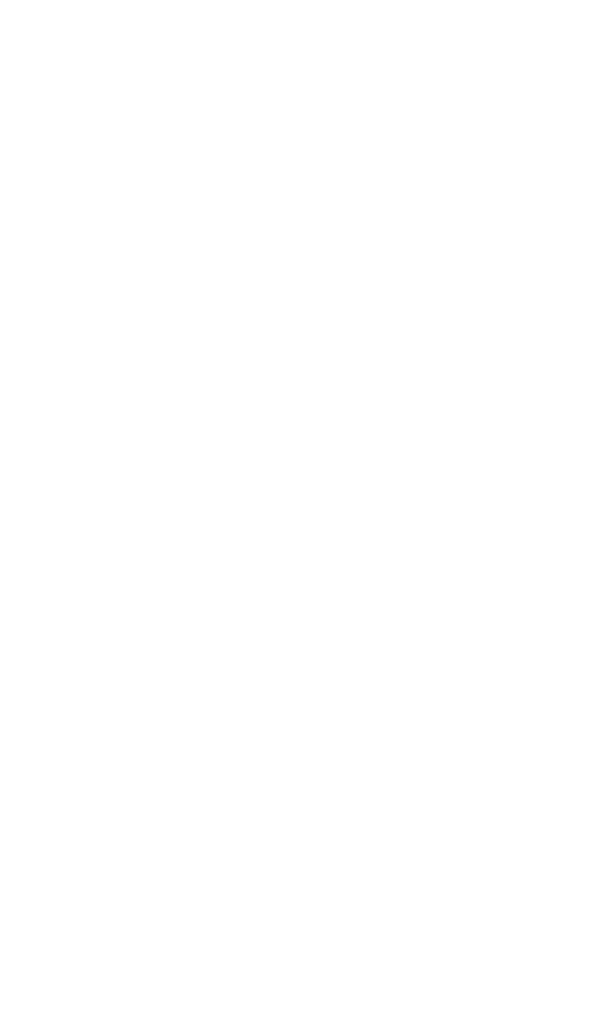
FIGURE A3 | Comparision of plasmid group 2 (pSP291-2 and pCTU3) using Artemis comparison tool